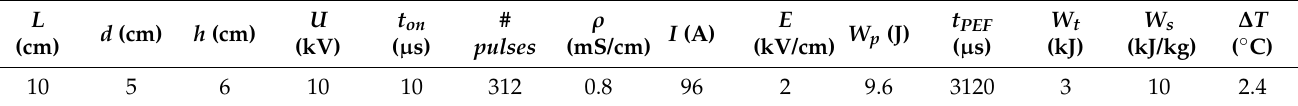
Table 1. PEF parameters calculation example for one eucalyptus experiment, for, f = 5